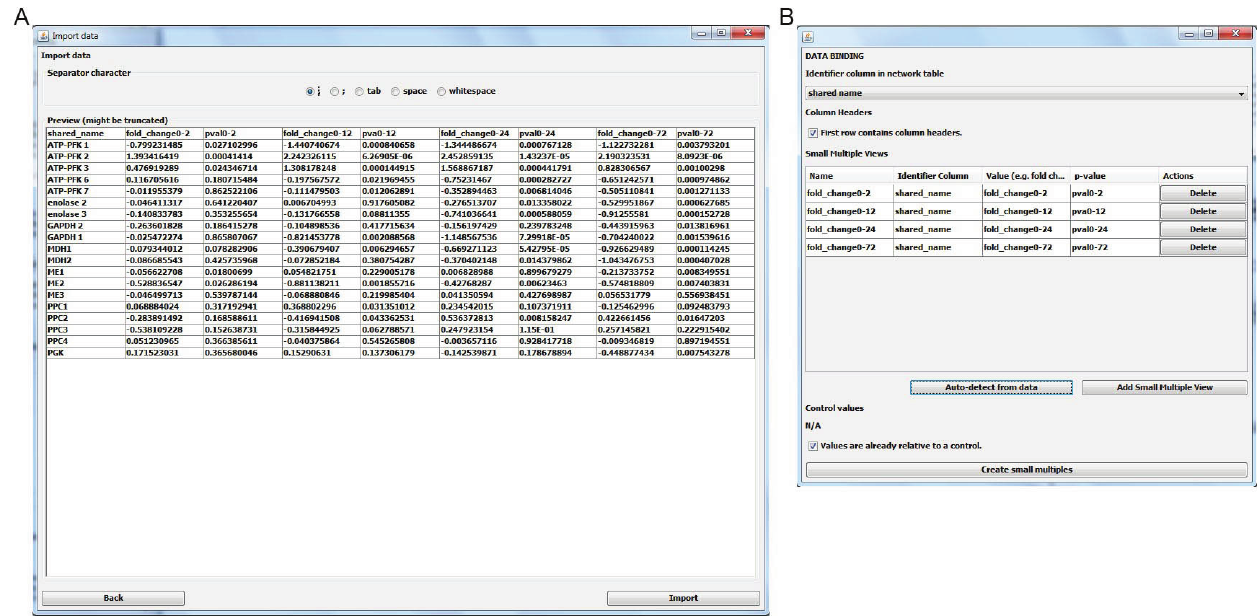
Figure 1. Importing data. ( A ) After selecting the text file with the input data, the user should select the field/column separator character (comma, semicolon, tab or whitespace). ( B ) On the data binding panel, the user should select the column that contains the identifier (“shared name” in our example) and configure the small multiples either by using the auto-detect functionality or manually (add small multiple